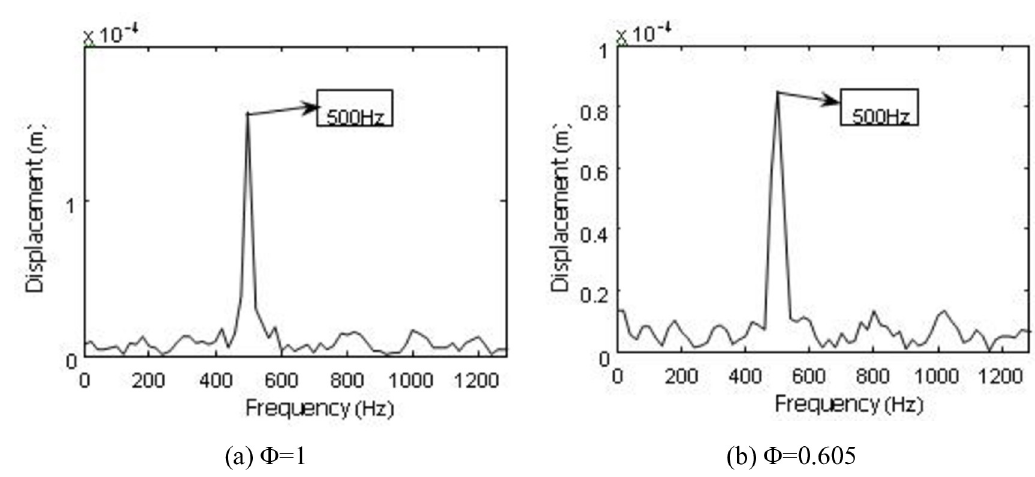
Fig 15. FFT of the second stage blade X direction displacement response.